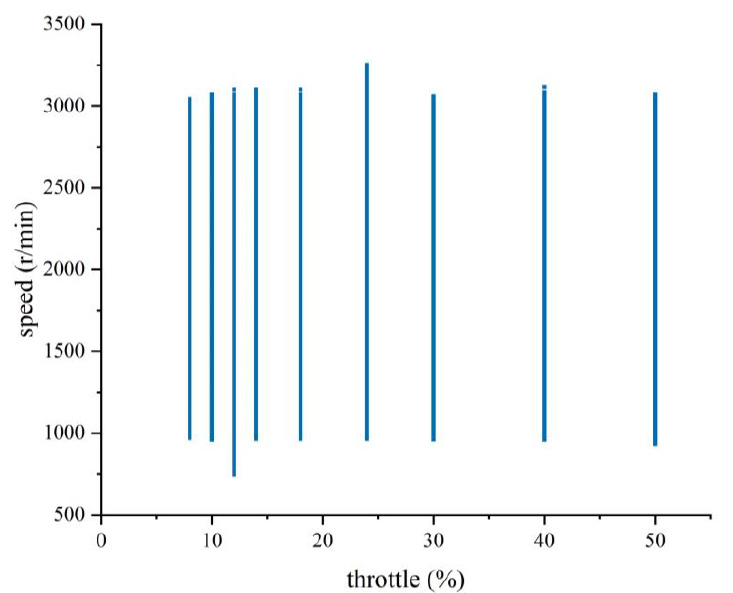
Figure 8. Engine operating envelop of the training set in terms of engine speed. and throttle valve percentage.